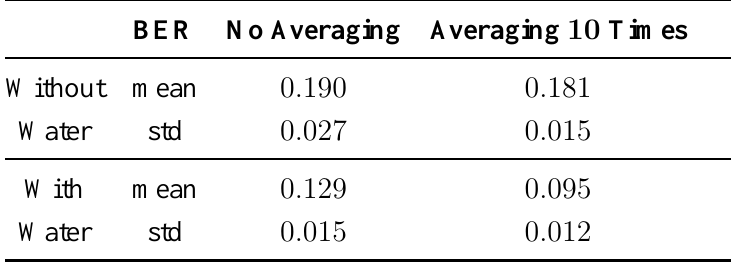
Table 4. Impact of Noise Reduction by Time Averaging at 100